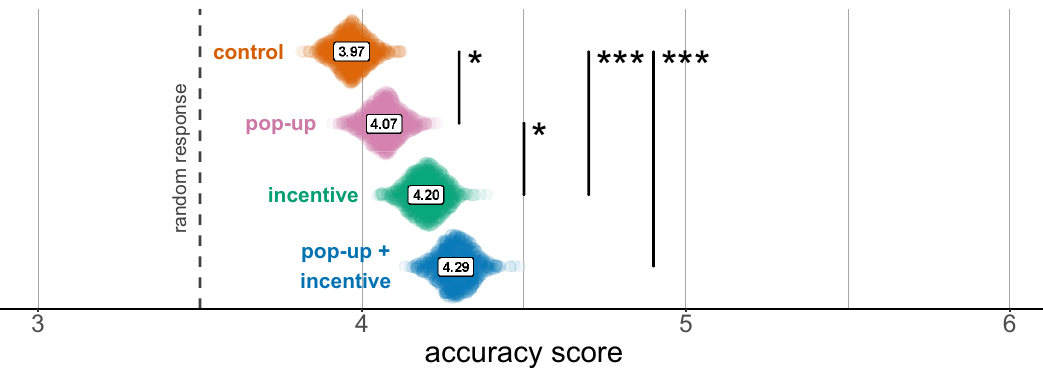
Figure 5. Bootstrap estimates of the average accuracy score by experimental condition (Min. 1, Max. 6, random response: 3.5). Asterisks refer to significance of contrasts in the ordinal logistic regression. * p < 0.05